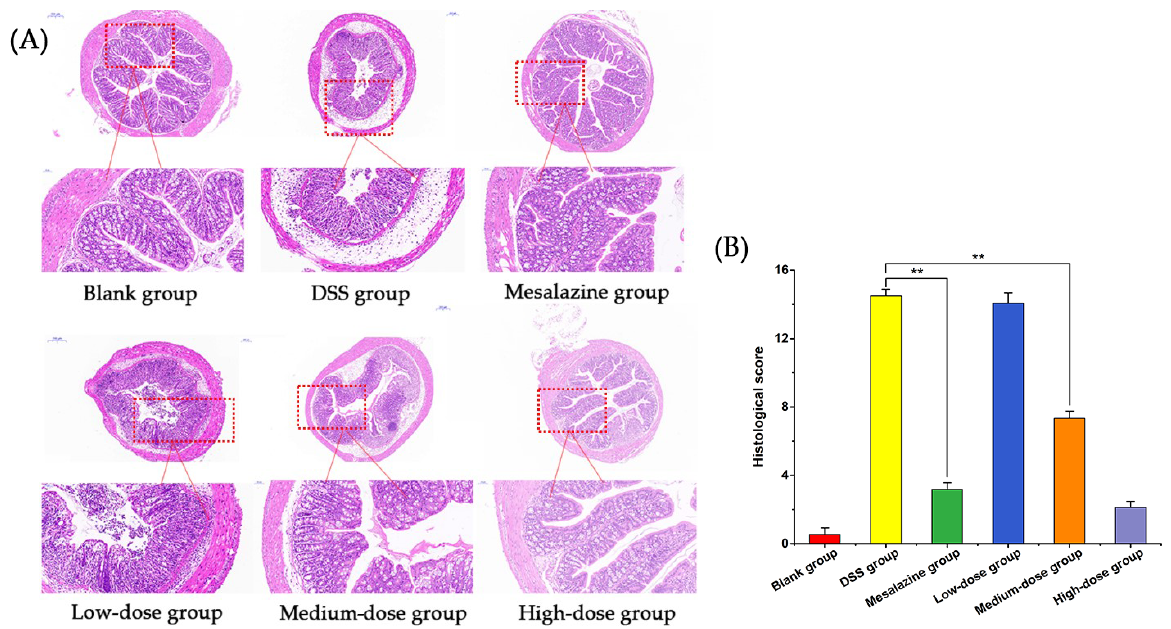
Figure 6. Effects of A. senticosus on colonic pathological changes in mice with DSS-induced colitis. ( A ) Mouse colonic tissue sections (magnification: ×40 and ×200). ( B ) Histopathological scoring of mouse colons. Note: For the comparison between the two groups, ** indicates extremely significant difference at p < 0.01.